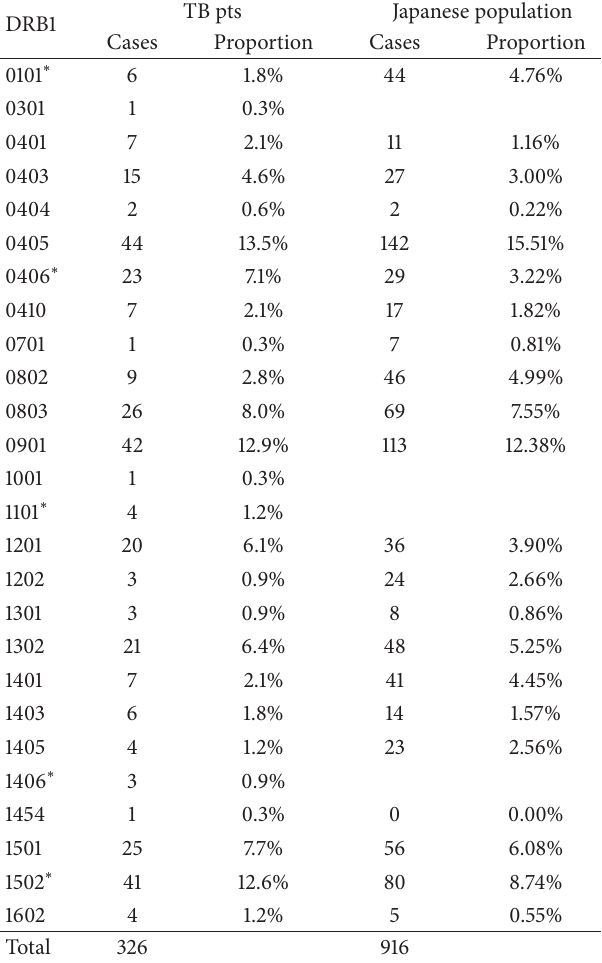
Table 3: Proportion of HLA class II DRB1 in Japanese TB patients and the general Japanese population. The asterisks show that the proportion of an HLA molecule in TB patients was significantly higher or lower than in the Japanese